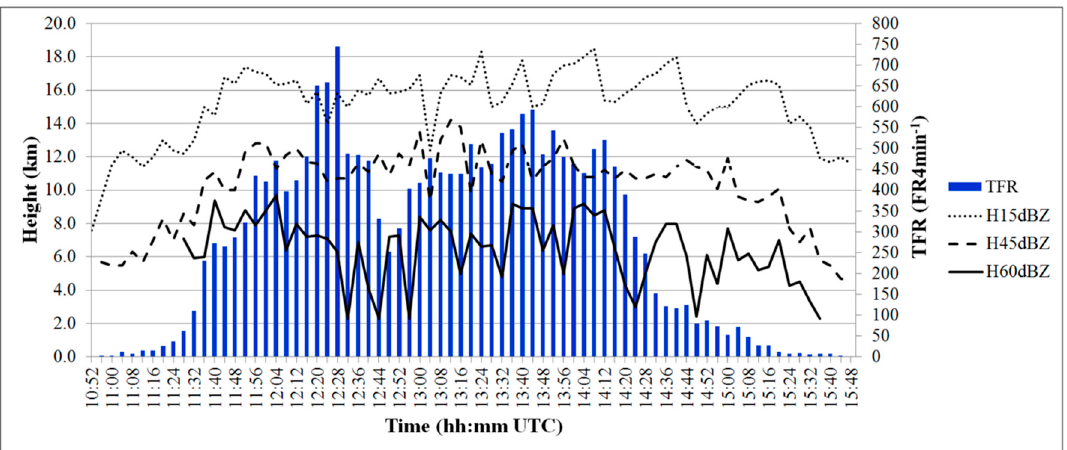
Figure 7. Number of total flashes per 4 min and above sea level (ASL) heights for the 15 dBZ, 45 dBZ and 60 dBZ reflectivity values as a function of time during the evolution of the supercell.